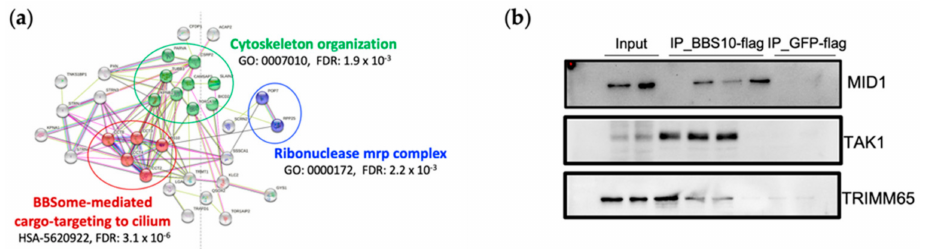
Figure 5. BBS10 protein-protein interaction (PPI) studies. ( a ) The BBS10 putative interactors were enriched for molecular processes in STRING (Search Tool for the Retrieval of Interacting Genes software). Clusters related to Cytoskeleton organization (GO:0007010, FDR 1.9 × 10 − 3 ), Ribonuclease mrp complex (GO:0000172, FDR 2.2 × 10 − 3 ), and BBSome-mediated cargo-targeting to cilium (HSA- 5620922, FDR 3.1 × 10 − 6 ) had results that were significantly enriched. ( b ) The more interesting BBS10-flag interactors were validated by Western blot analysis. The immunoprecipitates of the BBS10-flag were loaded on the SDS page. GFP-flag immunoprecipitates were used as a negative control. Each lane represents the immunoprecipitate derived from three different BBS10-flag cell clones. MID1: E3 ubiquitin-protein ligase Midline1; TAK1: also known as mitogen-activated protein 3 kinase 7 (MAP3K7); and TRIM65: Tripartite motif-containing protein. Two proteins in the dataset could be specifically linked between BBS10 depletion and the Warburg effect, possibly via mTORC1 up-regulation: the ubiquitin E3